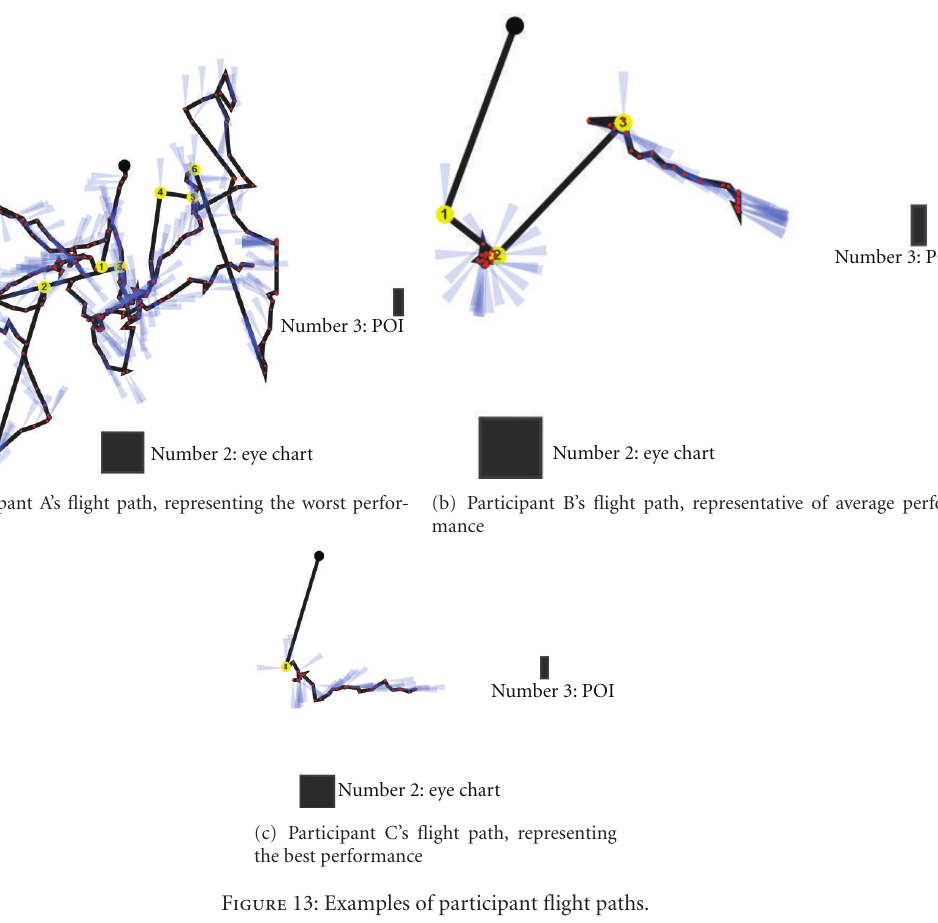
Figure 12: Examples of imagery seen by participants while finding and identifying the POI.